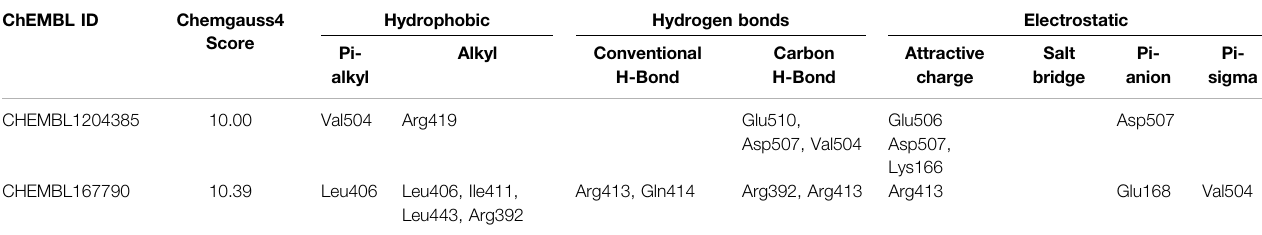
TABLE 3 | Chemgauss4 score and interaction types of the two best compounds from the FRED